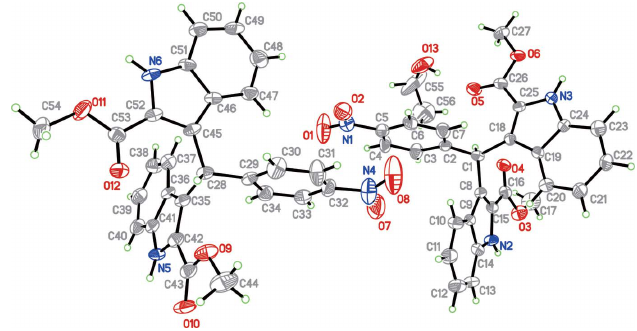
Figure 1 The molecular structure of the title molecule with the atom-labelling scheme. Displacement ellipsoids are drawn at the 30% probability